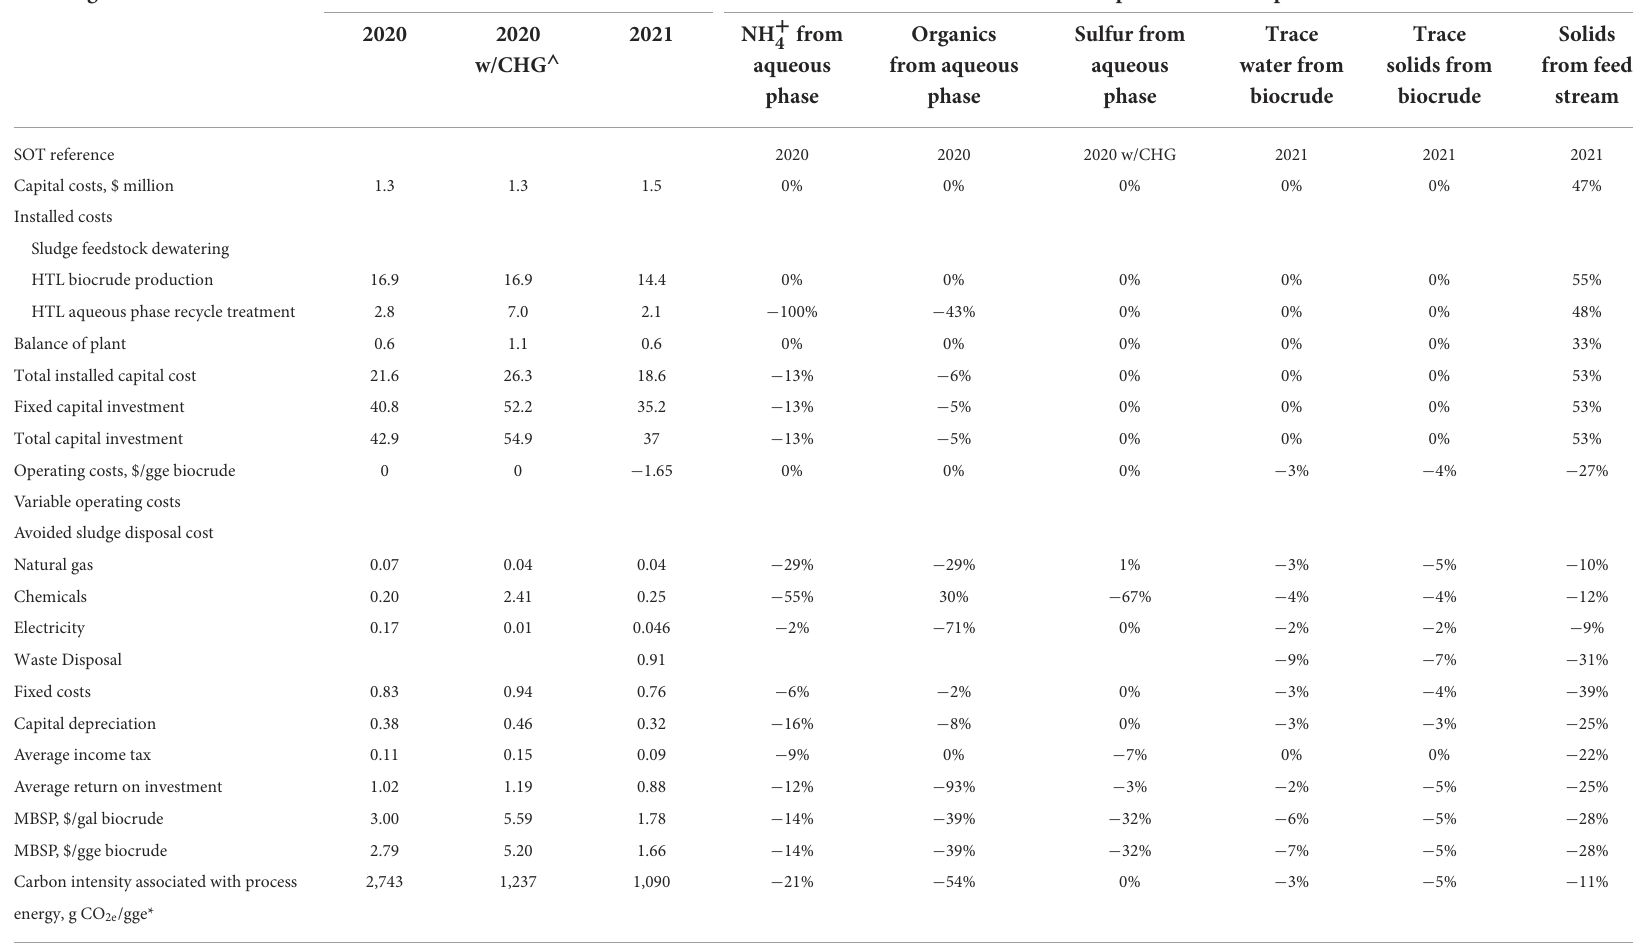
TABLE 2 Techno-economic estimates for the wet-waste HTL process separation challenge streams using the “ideal” separator